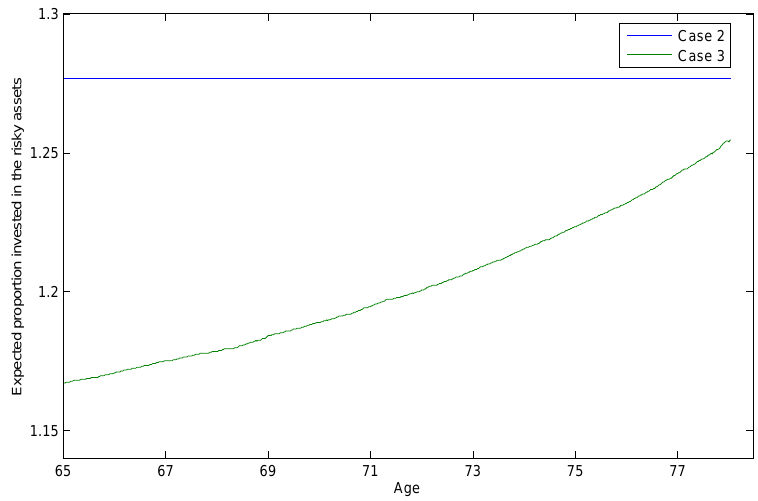
Figure 5. Expected proportion of surplus wealth, ˜ W , invested in the risky assets, or π ∗ W / ˜ W , by agents starting at age 65 in the healthy state with a total wealth of 10 Y . The expected paths are truncated at the optimal stopping times for case 2 and case 3, respectively. The differing behaviour of the case 3 target savers is